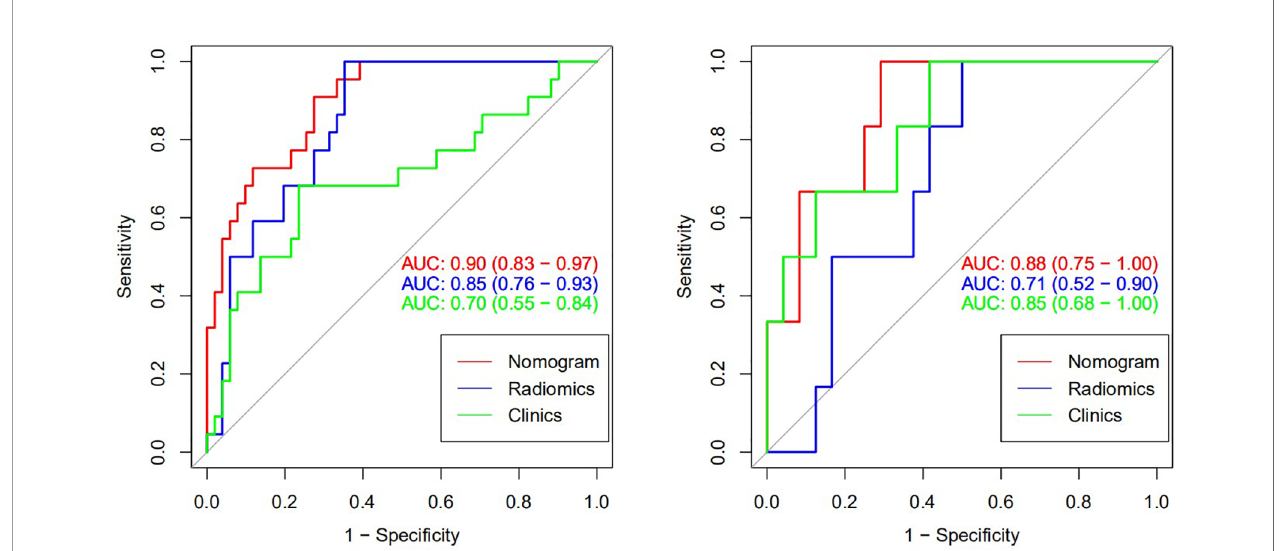
FIGURE 6 | Receiver operating characteristic (ROC) curve of csPCa predicted by three models (training set on the left and veri fi cation set on the